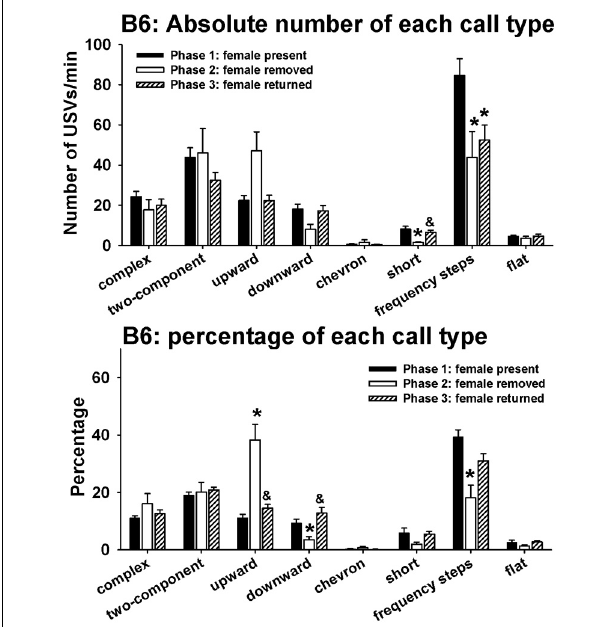
FIGURE 5 | Call repertoires in FVB males in phases 1, 2, and 3. USVs were detected from 12 out of 12 FVB in phase 1, 12 out of 12 FVB in phase 2, and 10 out of 10 FVB in phase 3. Only animals that emitted USVs were included in call category analysis. Analysis of absolute values of USV numbers indicated significant phase effects on complex, downward, chevron, frequency steps, and flat. Numbers of complex, downward, frequency steps, and flat were lower in phase 2 than on phase 1. These changes were reverted in phase 3, when the female returned. Analysis of percentages of call types indicated significant phase effects on complex, two-component, upward, downward, short, and flat. Percentages of complex, downward, and flat were lower in phase 2 than in phase 1, and the percentages of two-component, upward, and short were higher in phase 2 than in phase 1. These changes were reverted in phase 3, when the female returned. ∗ p < 0 . 05 vs. phase 1; & p < 0 . 05 vs. phase